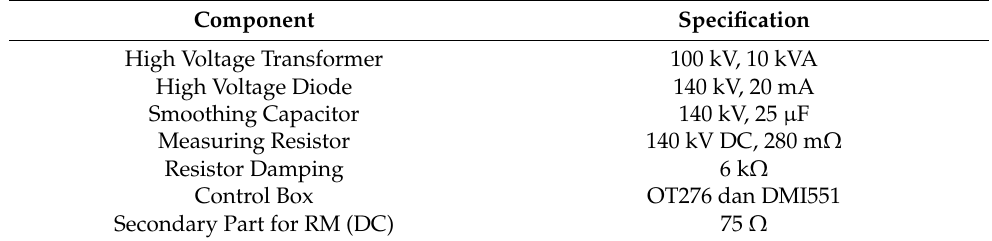
Figure 2. Circuit test at the laboratory. Table 1. Specifications of High Voltage Generator.